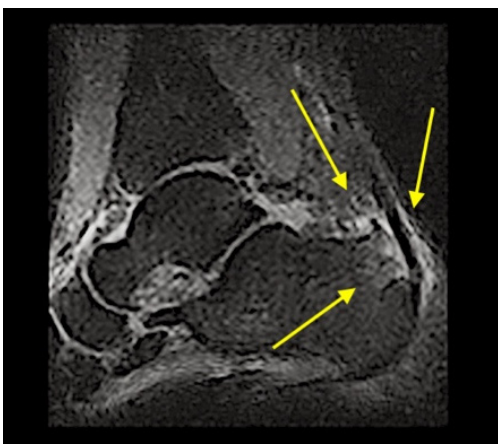
Figure 3. Magnetic resonance Imaging: The yellow arrows indicate: the degenerative changes in the Achilles tendon, bony oedema and the presence of retrocalcaneal bursitis, tendonitis phenomena and spongious oedema in the insertional region of Achilles tendon in the calcaneus.